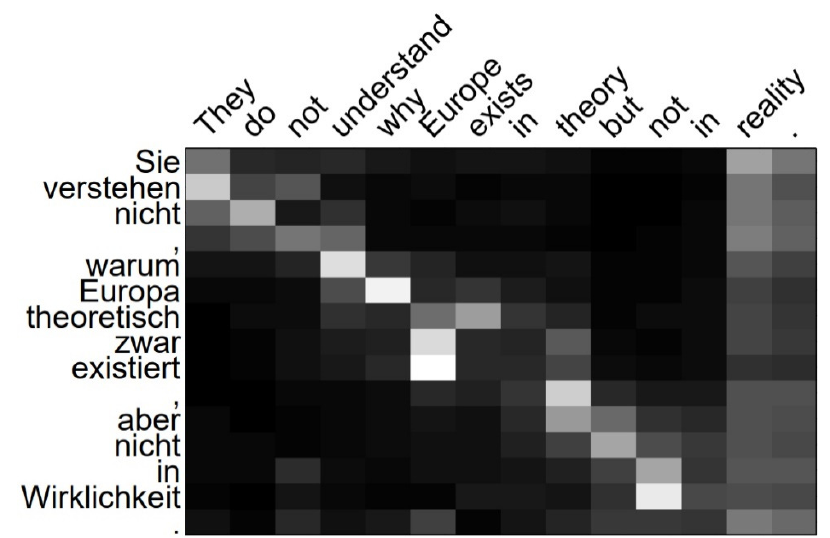
Figure 10. Visualization of the English to German translation attention process